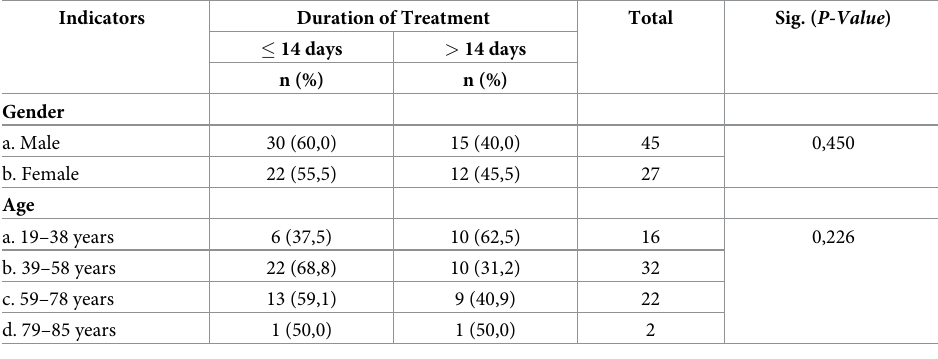
Table 1. Correlation between socio-demography and duration of treatment.